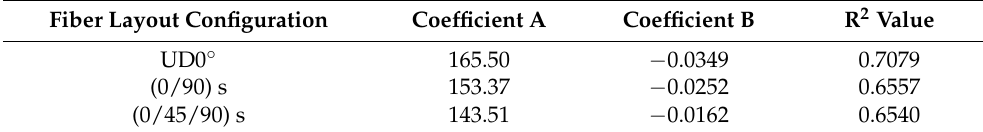
Table 1. Regression model